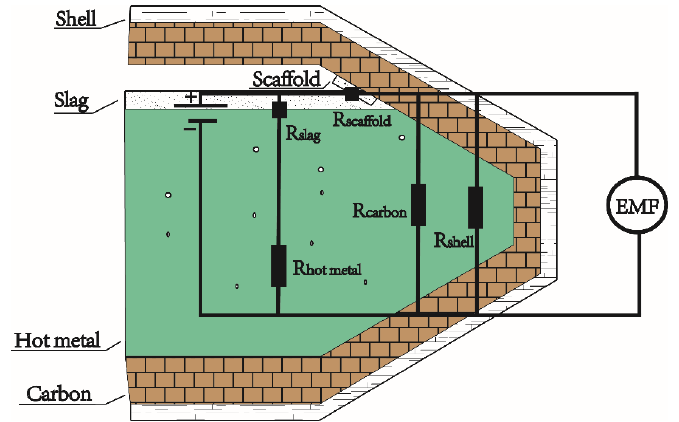
Figure 2. Possible electrical circuit proposal of that which occurs in the torpedo ladle.